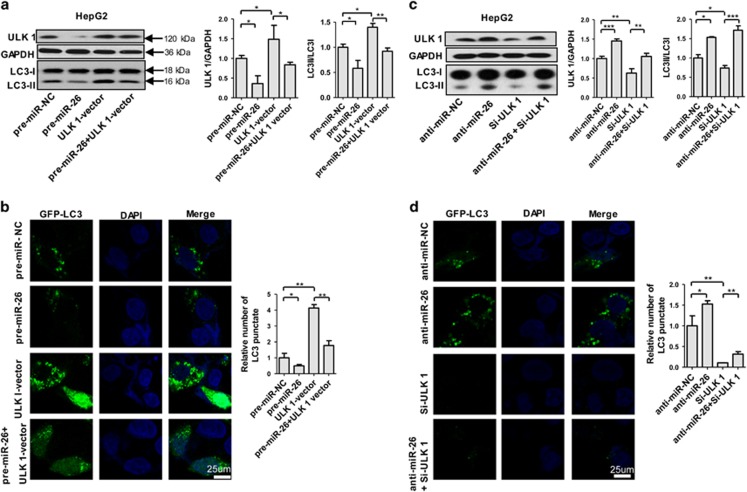
MiR-26a/b regulates autophagy through targeting ULK1. (a) Protein levels of ULK1 and LC3 were determined in HepG2 cells overexpressed with pre-miR-NC, pre-miR-26, ULK1-vector or pre-miR-26 plus ULK1-expressing plasmids. GAPDH was served as internal control. The right histograms represent quantitative analysis of ULK1 and LC3-II/LC3-I protein level. (b) Representative photographs of HepG2 cells transfected with GFP-LC3-expressing plasmids plus pre-miR-NC, pre-miR-26, ULK1-vector or pre-miR-26+ULK1-vector. (c) Protein levels of ULK1 and LC3 were detected in HepG2 cells overexpressed with anti-miR-NC, anti-miR-26, Si-ULK1 or anti-miR-26 plus Si-ULK1. (d) Representative photographs of HepG2 cells transfected with GFP-LC3-expressing plasmids plus anti-miR-NC, anti-miR-26, Si-ULK1 or anti-miR-26+Si-ULK1. The right histogram represents quantitative analysis of GFP-LC3 punctate from 10 micrographs. *P<0.05; **P<0.01; and ***P<0.001